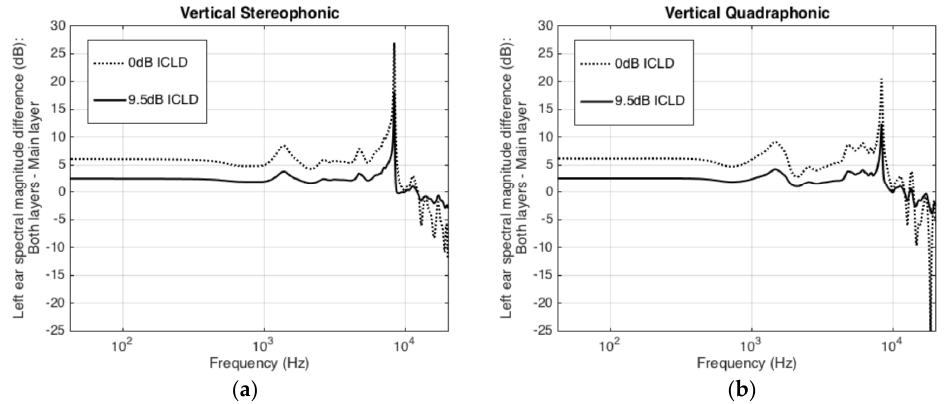
Figure 11. Difference in spectral energy between the main layer only and phantom image conditions for both presentation methods with 0-dB ICLD between the main and height layers and 9.5-dB ICLD (localisation threshold): ( a ) vertical stereophonic condition; ( b ) vertical quadraphonic condition.